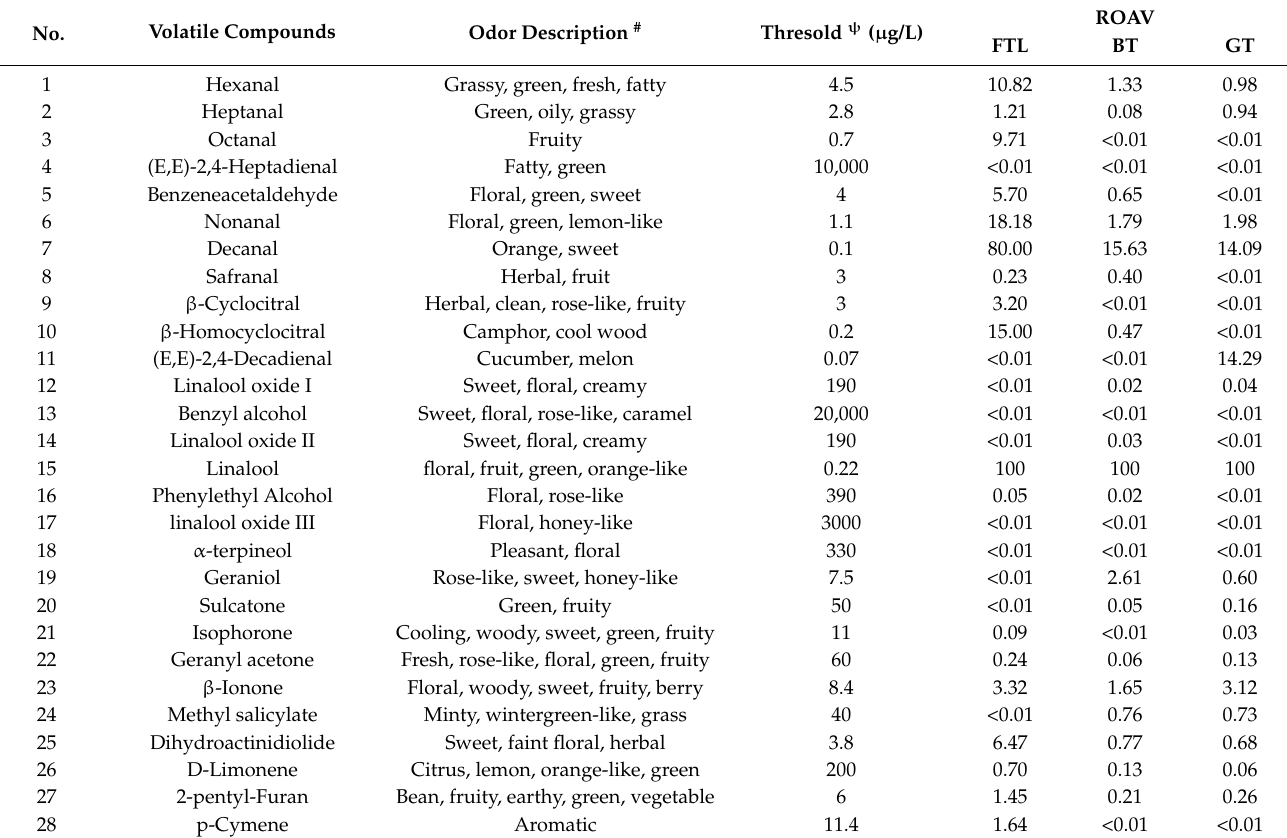
Table 3. The ROAV values of the main volatile compounds by GC-MS.